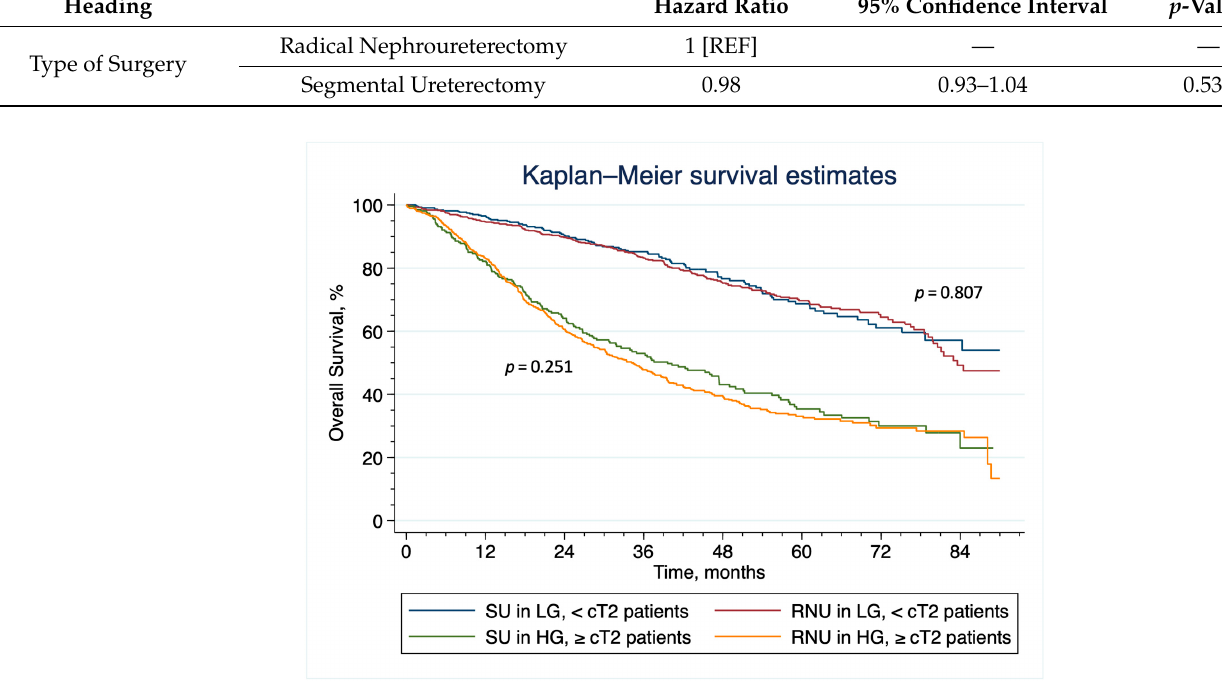
Figure 3. Kaplan–Meier analysis of overall survival in patients who received Radical Nephroureterectomy vs. Segmental Ureterectomy, according to grade and clinical T stage. SU= Segmental Ureterectomy, RNU= Radical Nephroureterectomy, LG= Low-Grade, HG= High-Grade, cT= Clinical T Stage.